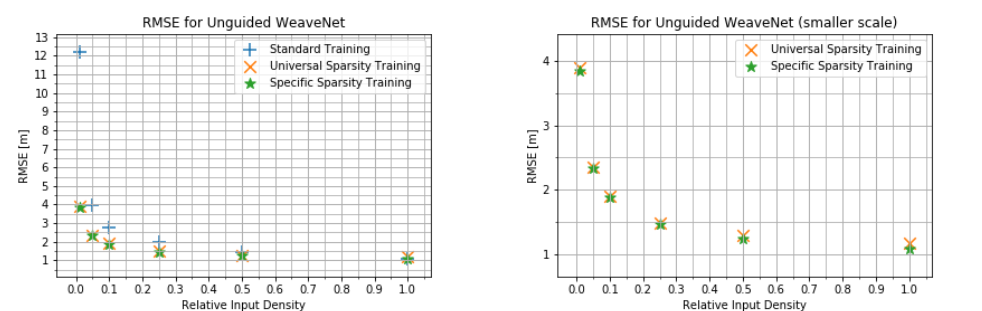
Figure 5. RMSE for the unguided WeaveNet for various input densities for different training modes (different scales).